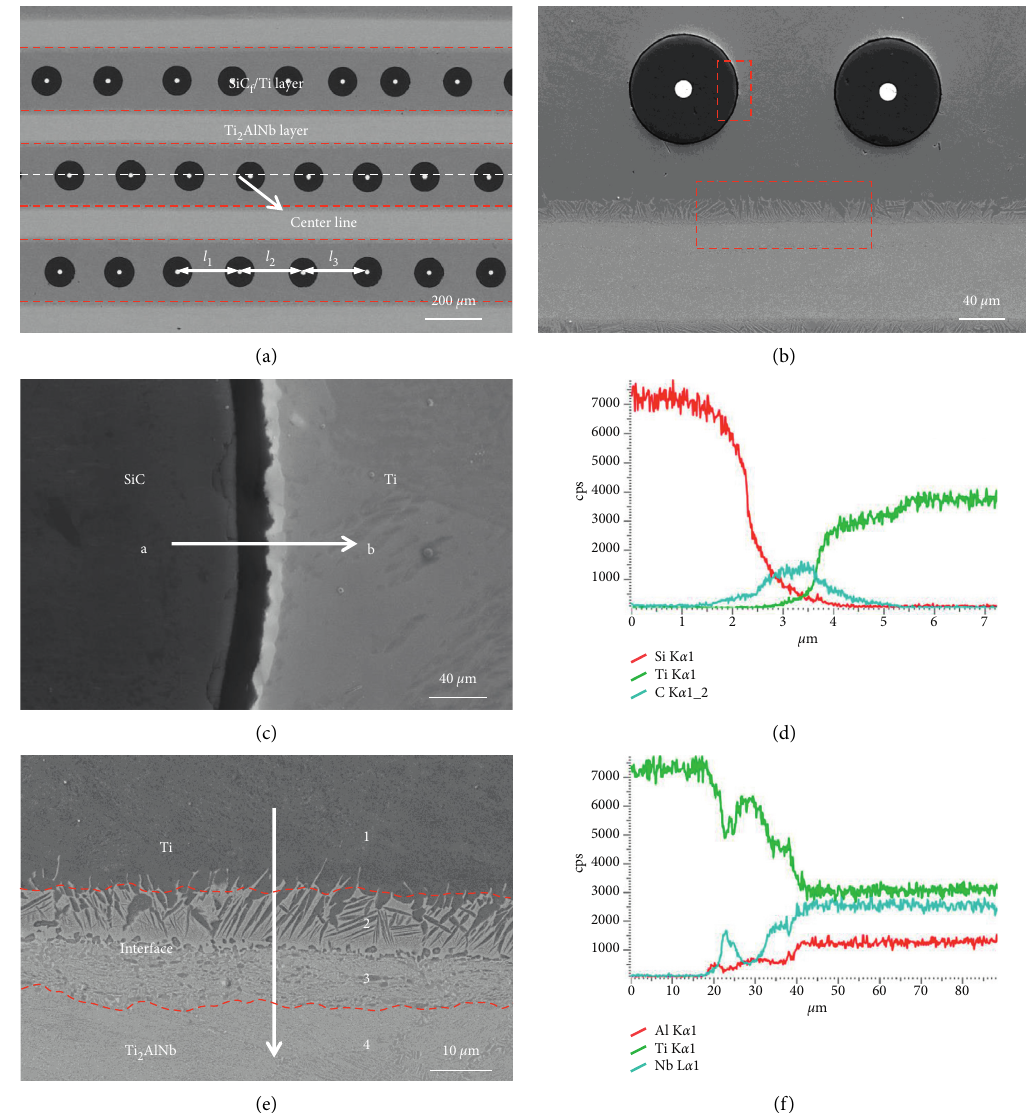
Figure 5: Microstructure of the composite: (a) overall microstructure; (b) microstructure of one laminated component; (c) microstructure of the SiC f /Ti interface; (d) EDS line scanning over the SiC f /Ti interface; (e) microstructure of the Ti/Ti 2 AlNb interface; (f) EDS line scanning over the Ti/Ti 2 AlNb